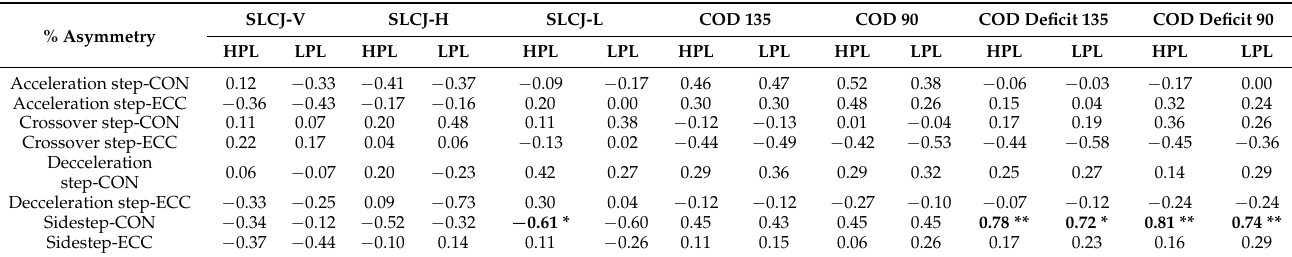
Table 2. Spearman’s r correlations between inter-limb asymmetry scores and unilateral jump and COD performance.